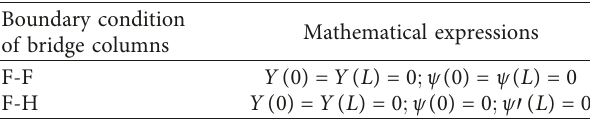
Table 1: Boundary conditions of bridge columns. Boundary condition Mathematical of bridge columns